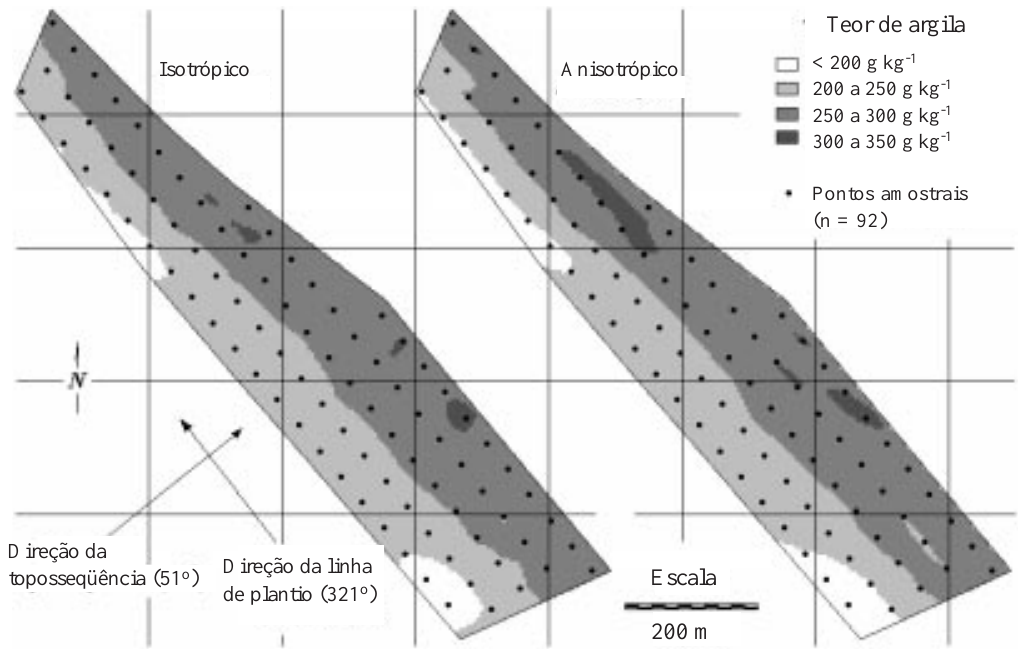
Figura 3. Mapas do teor de argila superficial, obtidos por krigagem com modelo isotrópico e